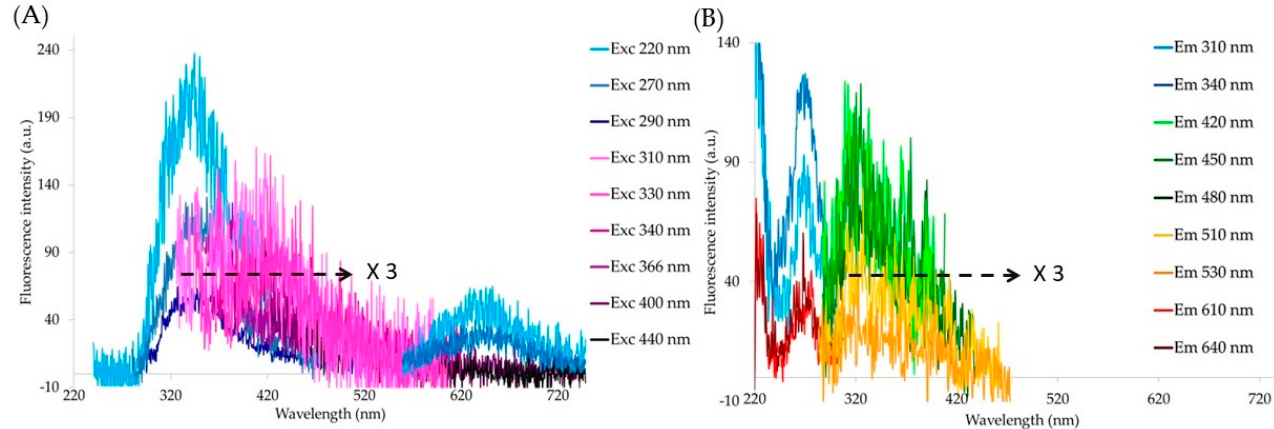
Figure 5. Emission ( A ) and excitation ( B ) spectra recorded from the preparation extract from black cat hairs. To allow the shapes of the spectra covering the 320–620 nm range ( A ) and the 300–470 nm range ( B ) to be better appreciated, their amplitudes are increased with respect to the fluorescence intensity scale a.u. values as indicated by the arrow in each panel. Excitation and emission conditions are indicated by colors on the right. The aqueous extract solution obtained from the mosquito eggs shows spectra similar to those measured from black cat hairs in the shorter spectral region, or in the red one. Much more defined excitation and emission profiles are detected in the 320–420 nm or in the 400–600 nm range, respectively. Interestingly, excitation at wavelengths longer than 310 nm results in a series of emission spectra showing a red shift in the maximum peak accompanied by a decrease in the amplitude, similarly to what is observed for both synthetic melanin and for the advanced melanization step (Figure 6A).